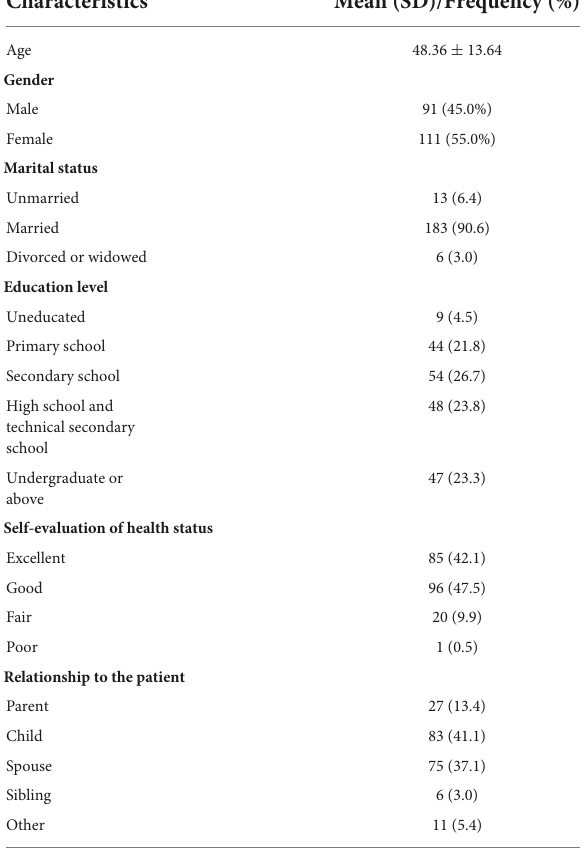
TABLE 1 Distribution of participant characteristics ( N =